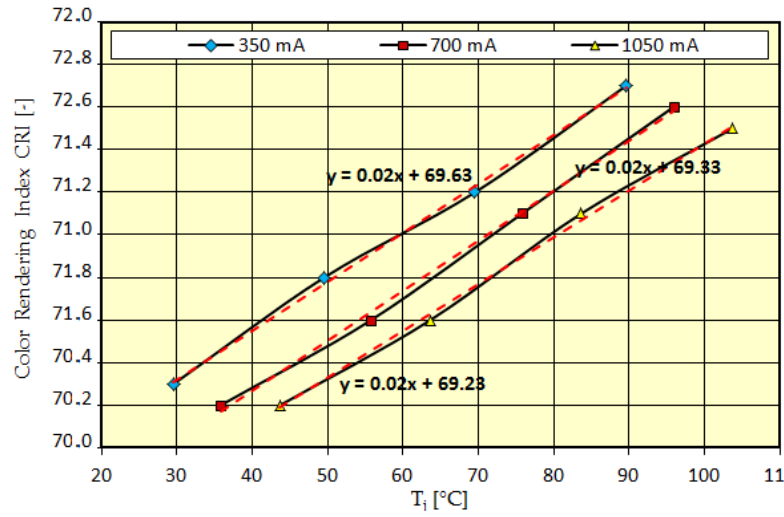
Figure 3. The effect of T p and T j temperature on lighting parameters for the studied LED source: ( a ) luminous flux Φ ; ( b ) CCT and ( c ) CRI .